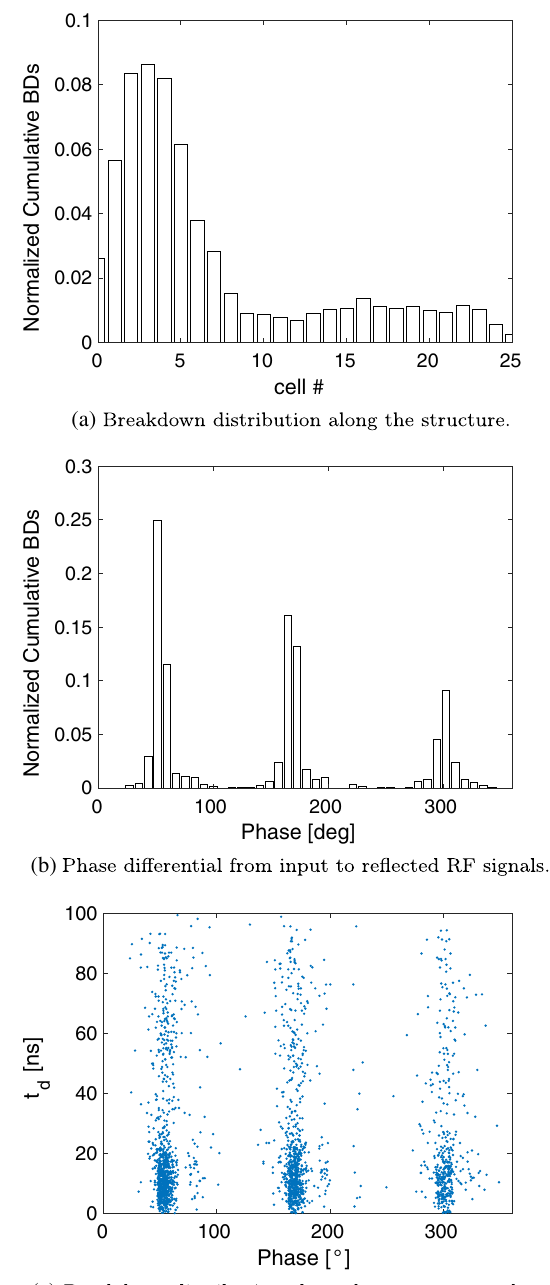
FIG. 13. Breakdown distributions inside the structure normal- ized to the total number of